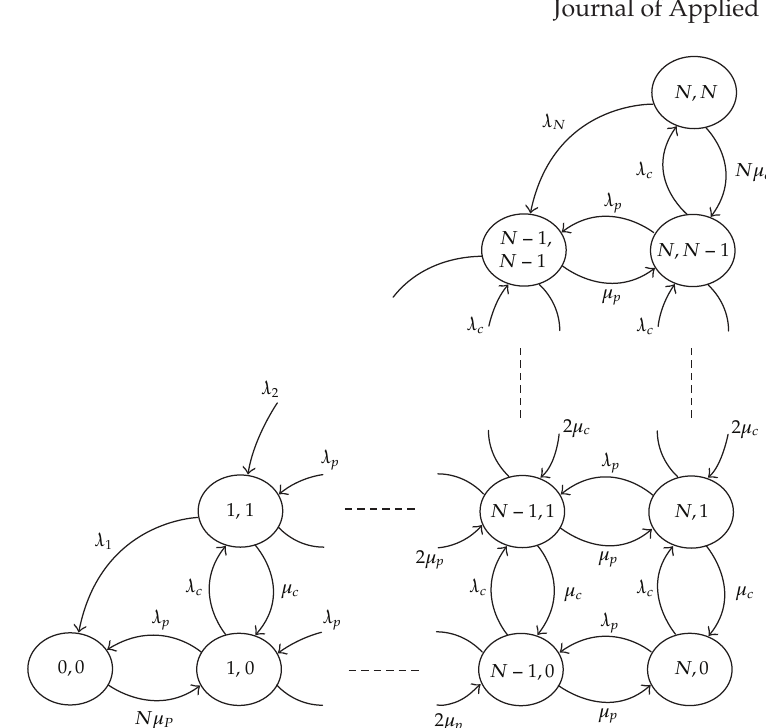
Figure 1: Two-dimensional queue for the CR system. Circles labelled i,j represent states, and possible transitions are given by arrows with the flow rates also